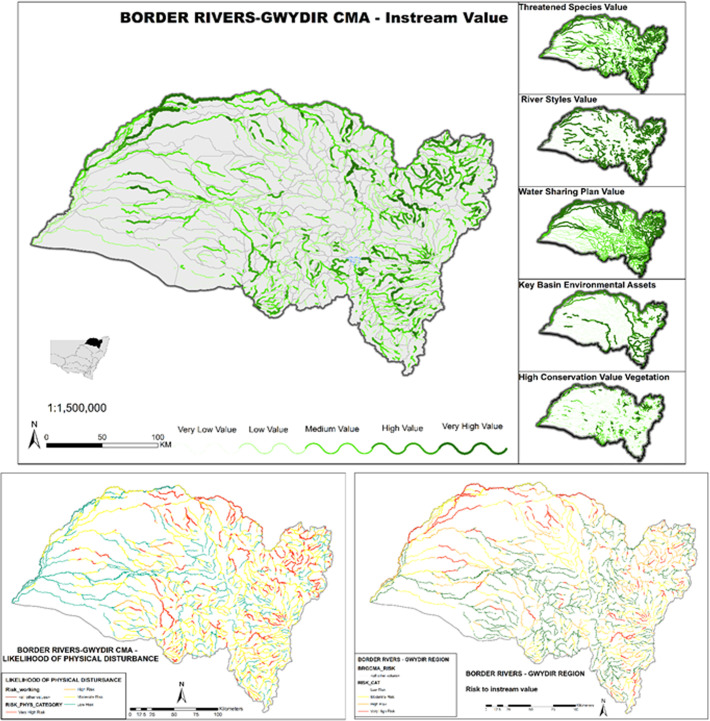
High Ecological Value Aquatic Ecosystem (HEVAE) and prioritisation based on risk of physical disturbance to instream values at the catchment and reach scales.Instream value contains analysis of the values such as geomorphic (River Styles), threatened species, water sharing, environmental assists and high conservation vegetation. The likelihood of physical disturbance to these values is then assessed to produce risk to instream values maps that can be used in prioritisation activities.